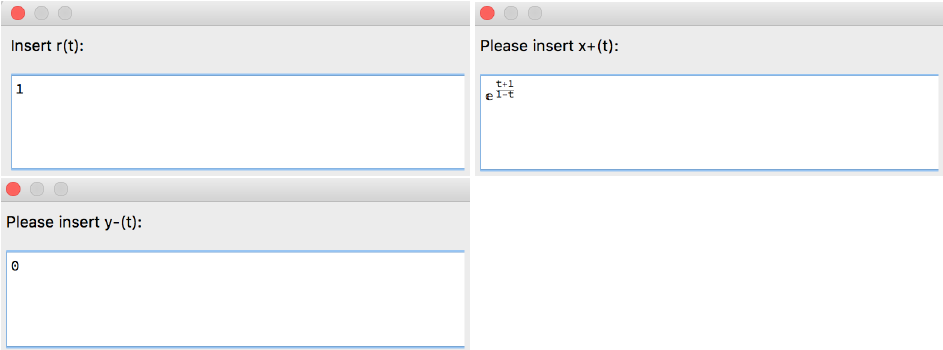
Figure 66. Part of the structure of the [SInt] 2.0 algorithm responsible for the input options.